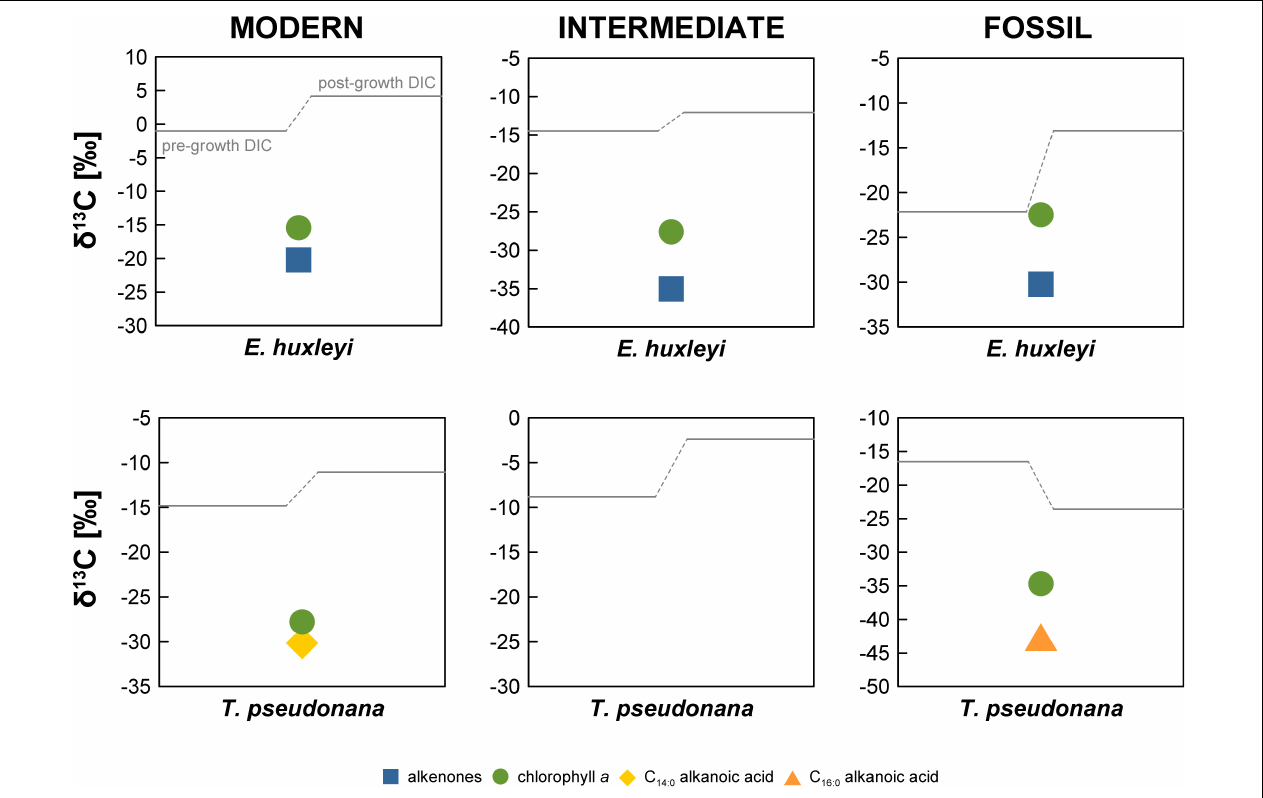
FIGURE 3 | Stable carbon isotopic composition ( δ 13 C in TABLE 1 | Sample amounts of DIC and purified compounds.